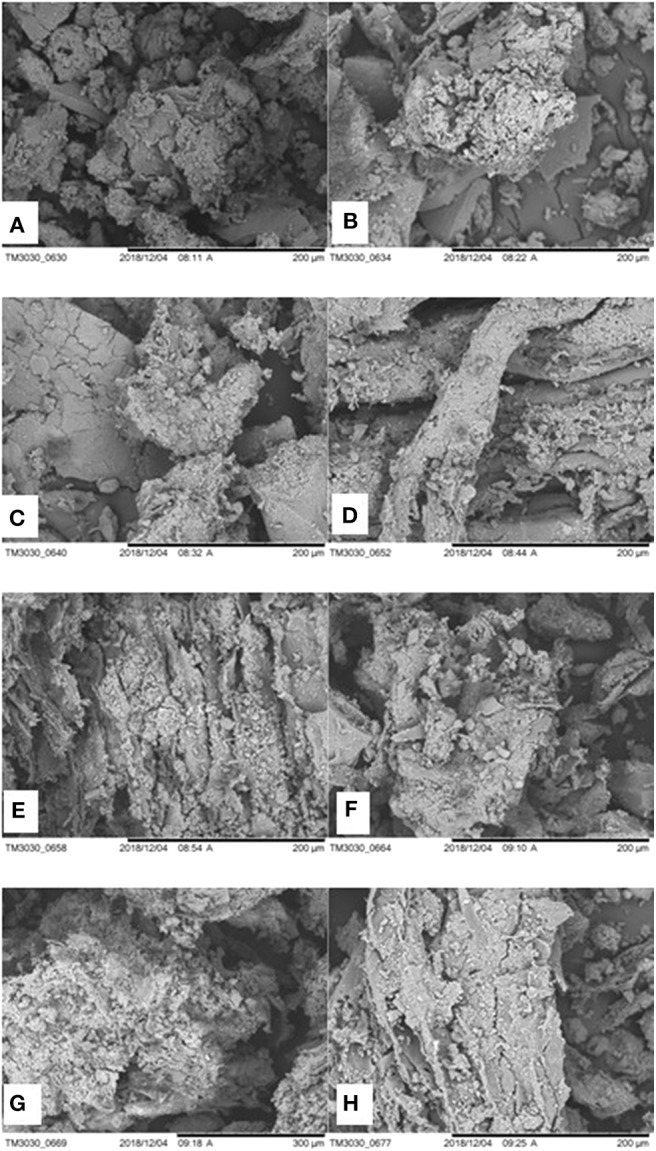
SEM images of crude PL and assays after US pre-treatment. Where: (A) crude PL; (B) Assay 1; (C) Assay 2; (D) Assay 3; (E) Assay 4; (F) Assay 5; (G) Assay 6; (H) Assay 7.